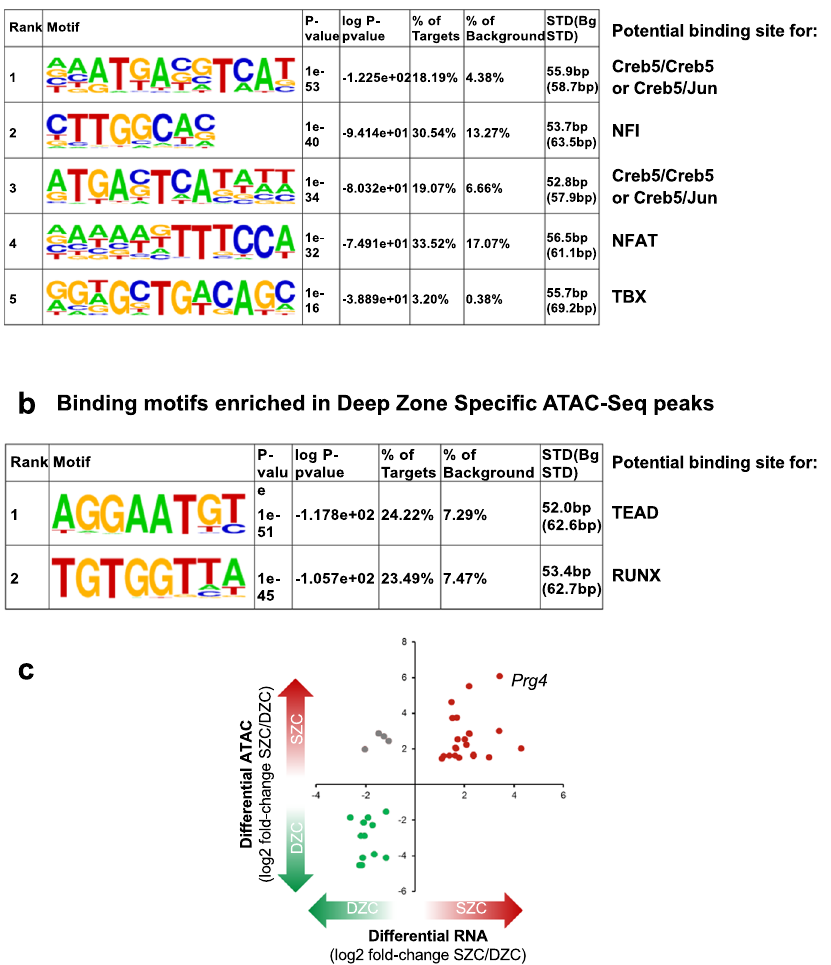
Fig. 6 Transcription factor binding sites that are enriched in ATAC-Seq peaks which display differential accessibility in super fi cial versus deep zone chondrocytes. a Homer motif analysis of ATAC-Seq peaks that are enriched in SZCs versus DZCs indicated that binding sites for Creb5, N fi , Nfat, and Tbx TFs are enriched in super fi cial zone-speci fi c ATAC-Seq peaks. b Homer motif analysis of ATAC-Seq peaks that are enriched in DZCs versus SZCs indicated that the binding sites for Tead and Runx TFs are enriched in deep zone-speci fi c ATAC-Seq peaks. In both ( a , b ), the frequency of these sequence motifs in zone-speci fi c ATAC-Seq peaks (% of targets) versus their frequency in the genome (% background) is displayed. c Correlation between ATAC-Seq sites and zone-speci fi c gene expression. A high correlation was observed between zone-speci fi c ATAC-Seq sites (located ≤ 25 kb from the transcription start site) and zone-speci fi c gene expression in both SZCs and DZCs. This correlation was highest at the Prg4 locus, where four distinct regions (E1 – E4) were selectively accessible in